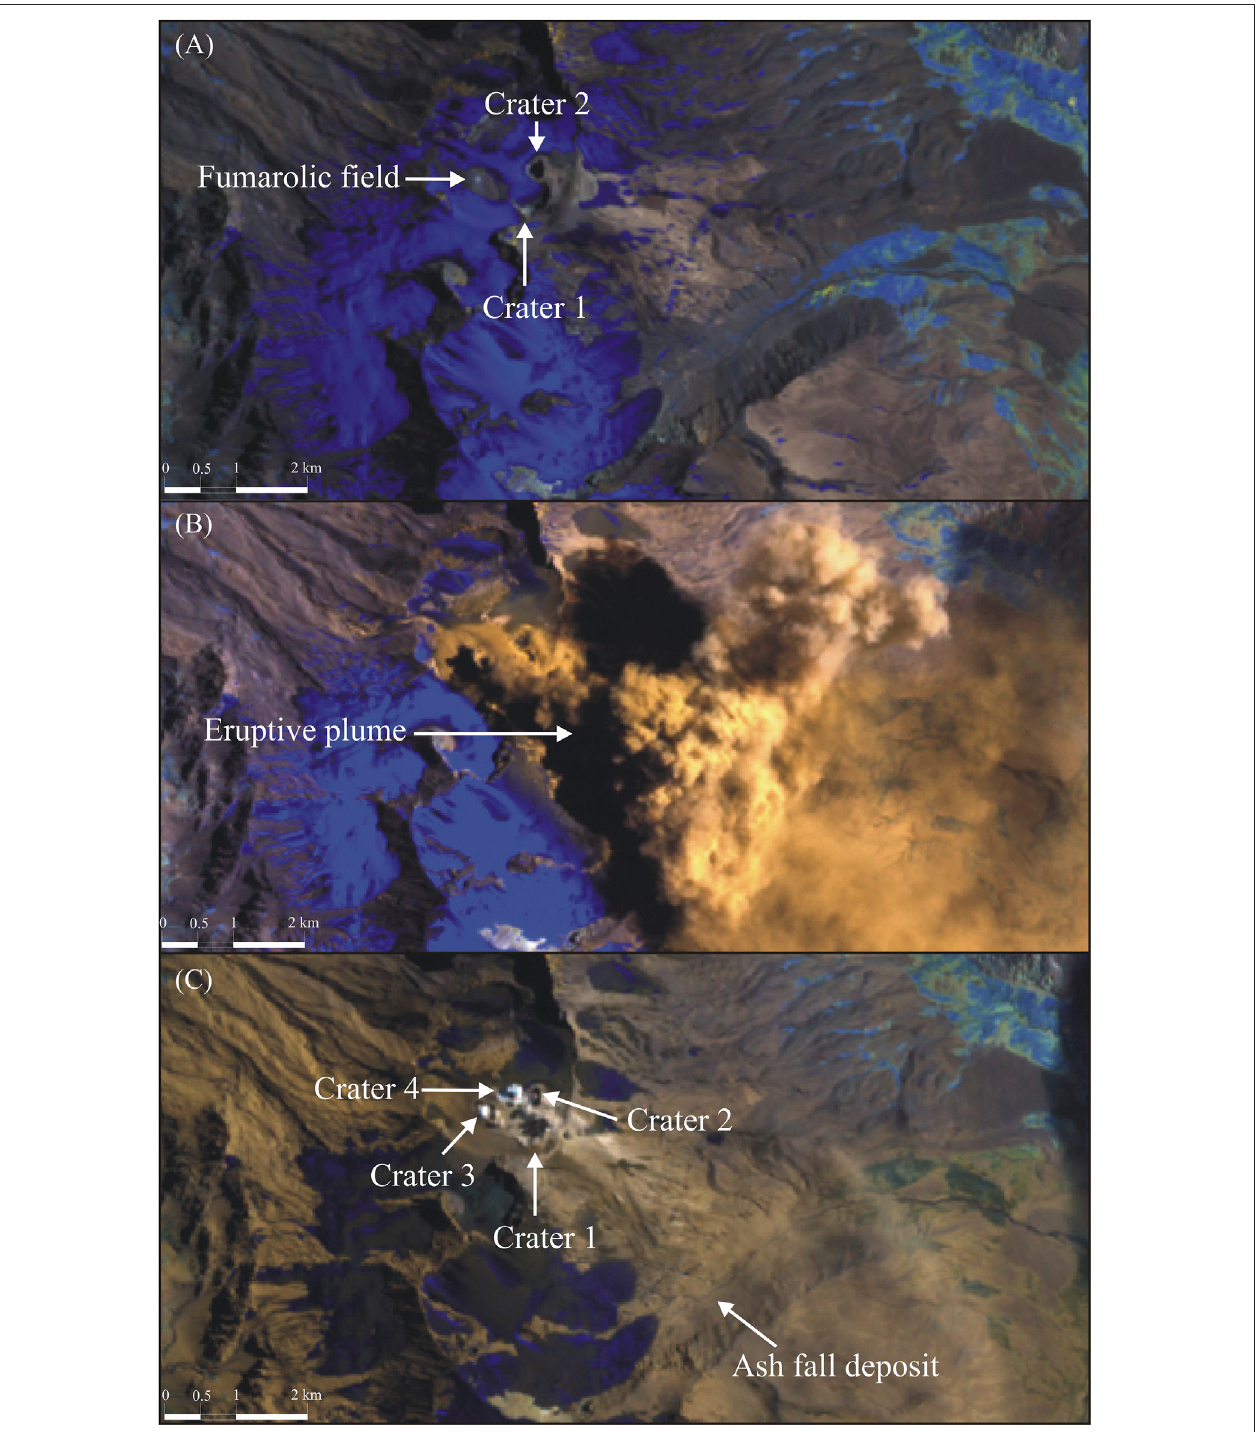
FIGURE 3 | (A) Landsat TM (combination 754 in RGB) showing Crater Lakes 1 and 2 (February 4, 1991). (B) Landsat TM (combination 754 in RGB) showing the eruptive plume (February 11, 1991). (C) Landsat TM (combination 754 in RGB) showing Crater Lakes 1, 2, and the new Craters 3 and 4. Ash fall deposit is also shown (February 27, 1991).